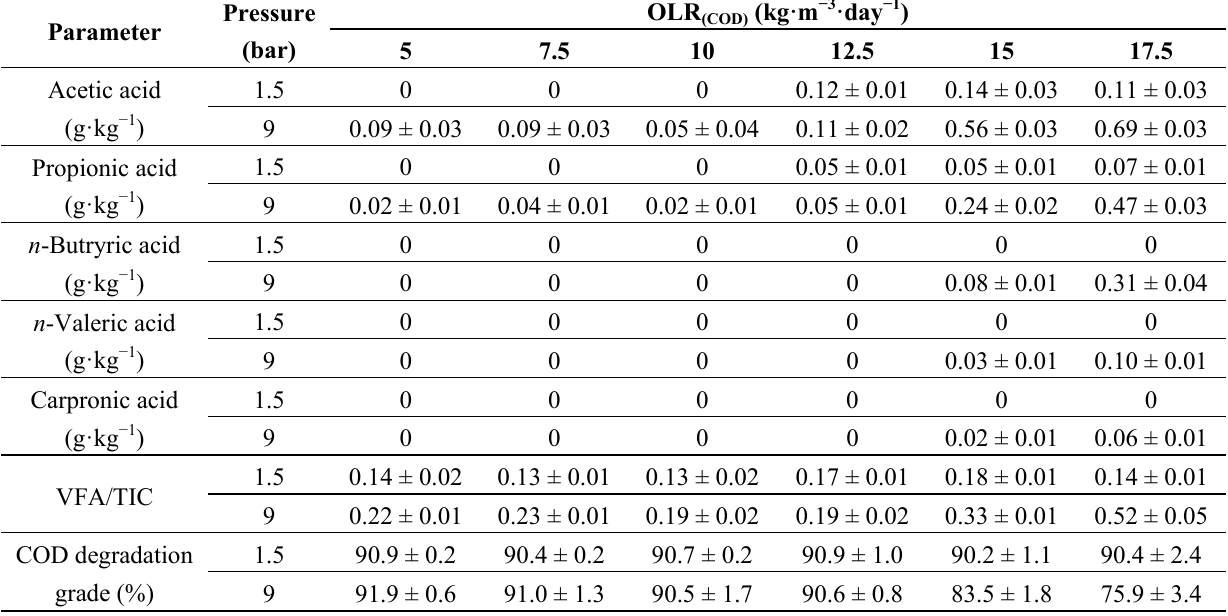
Table 4. VFA concentration in the effluent of the anaerobic filter, COD degradation grade and alkalinity buffer capacity at different OLR and pressure